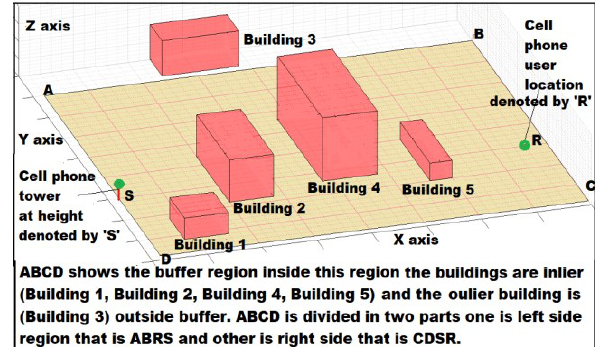
Figure 7. Set up for the path around the sides of the building